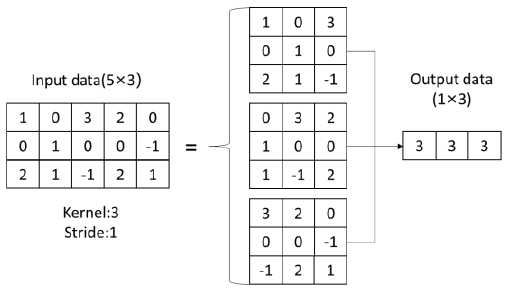
Figure 4. One-dimensional max pooling process.